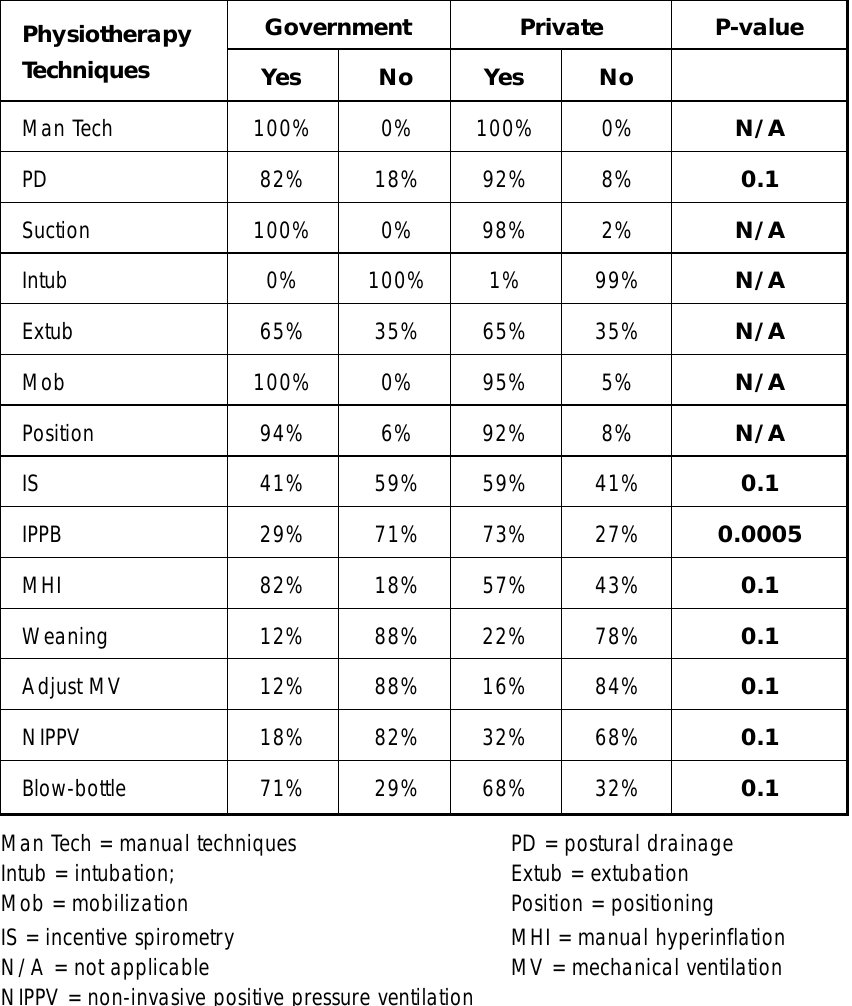
Table 3: Percentage of respondents in South African survey that use specific physiotherapy techniques in ICU, categorized by hospital sector. Physiotherapy Government